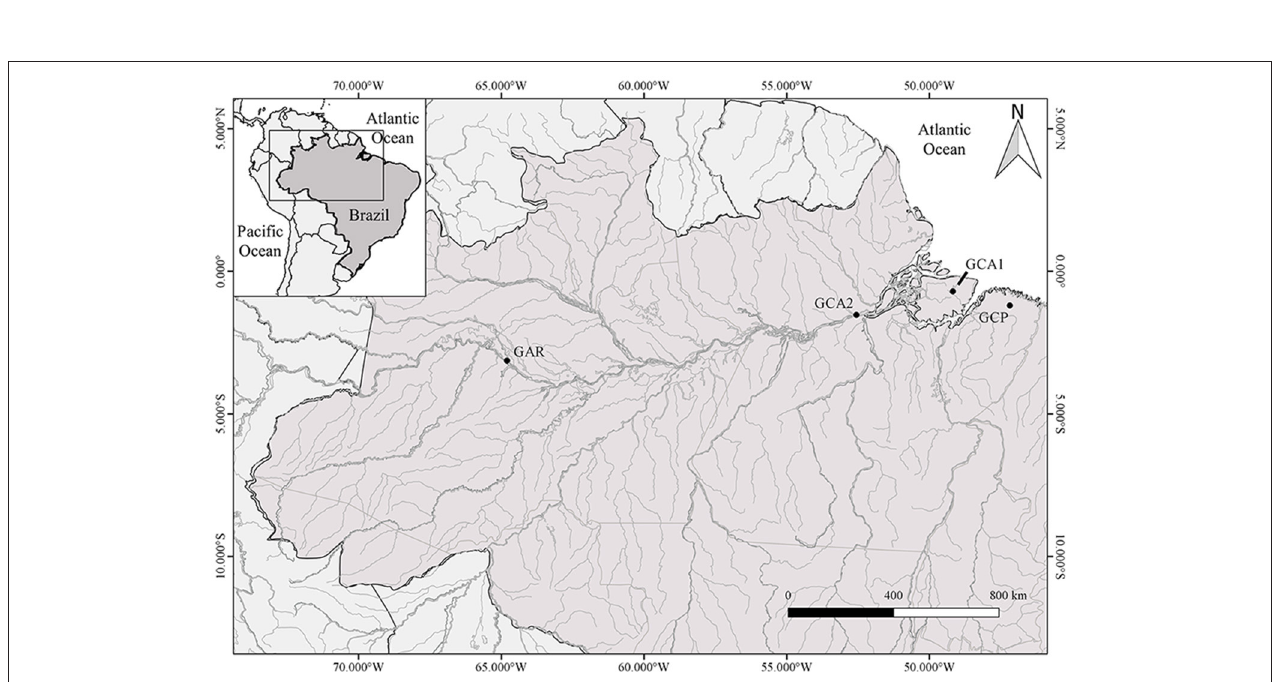
FIGURE 5 | A map of Northern Brazil showing the geographical distribution of the samples from the four species of Gymnotus analyzed by whole chromosome painting. G. carapo 2 n = 42 (GCA1, Nagamachi et al., 2010, Santa Cruz do Arari, Marajo Island), G. carapo 2 n = 40 (GCA2, Nagamachi et al., 2010, Almerim, Amazon river drainage), G. capanema (GCP, Nagamachi et al., 2013, Capanema, Rio Açaiteuazinho drainage) and G. arapaima (GAR, present study, Mamirauá Sustainable Development Reserve, Amazonas, Brazil).